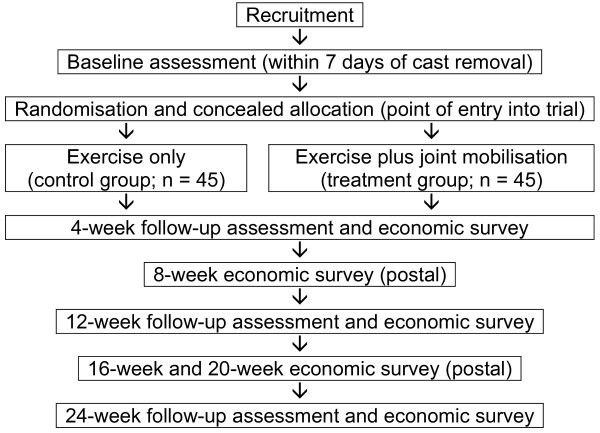
Experimental protocol.